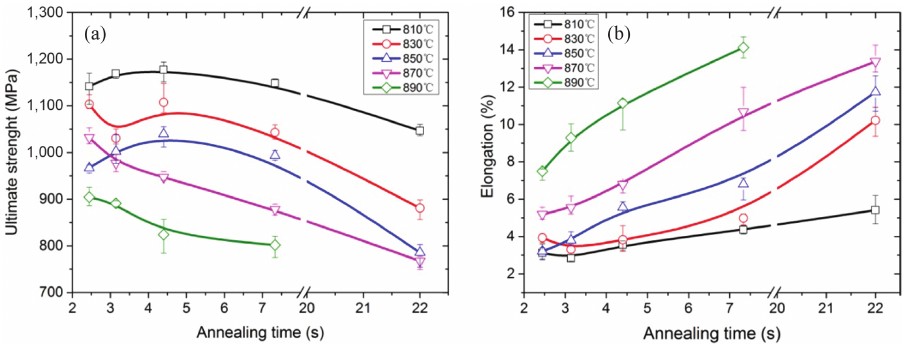
Figure 4: Ultimate strength and elongation of the deformed specimen with engineering strain of 46.6% as a function of annealing